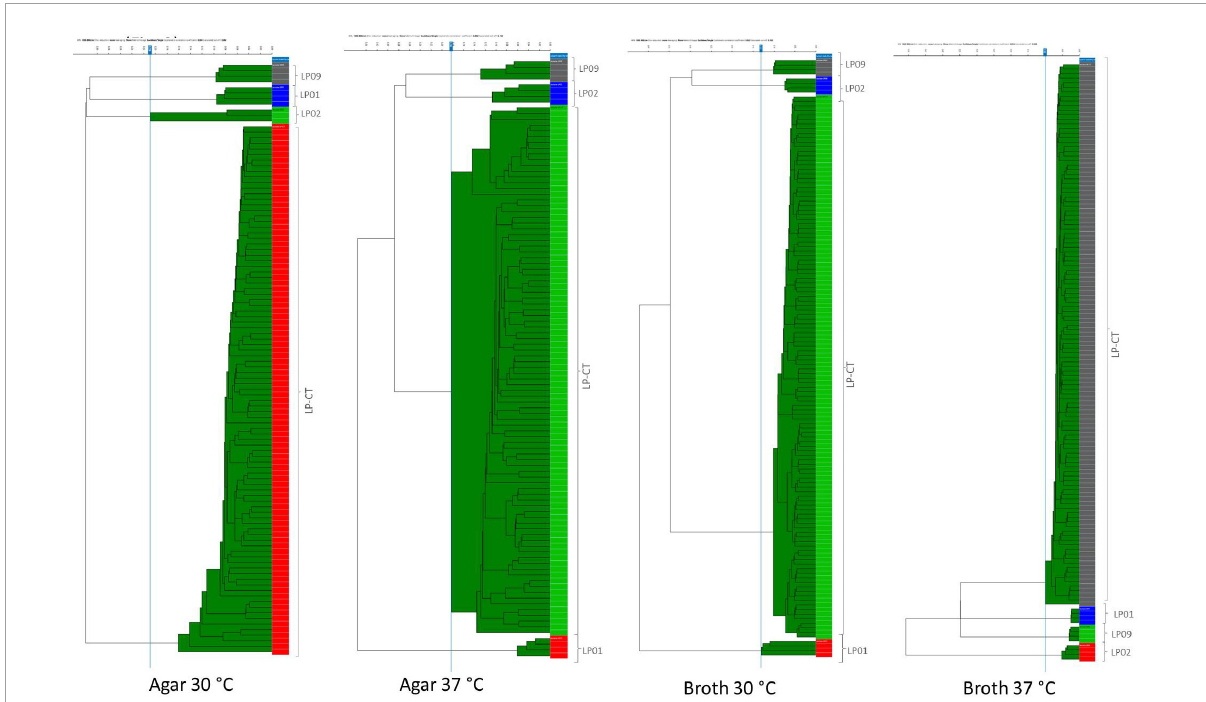
FIGURE3 HCA results for the four incubation protocols from scheme 2 and scheme 1. LP01, LP02, LP09 are represented with different colors by their four technical replicates (on the right side of each image); LP-CT is represented by all its technical and biological replicates. On the left side of each image, the IR Biotyper clustering of the spectra into the corresponding isolates is shown, as well as the relationship between the different isolates (indicated by the branches of the dendrogram).